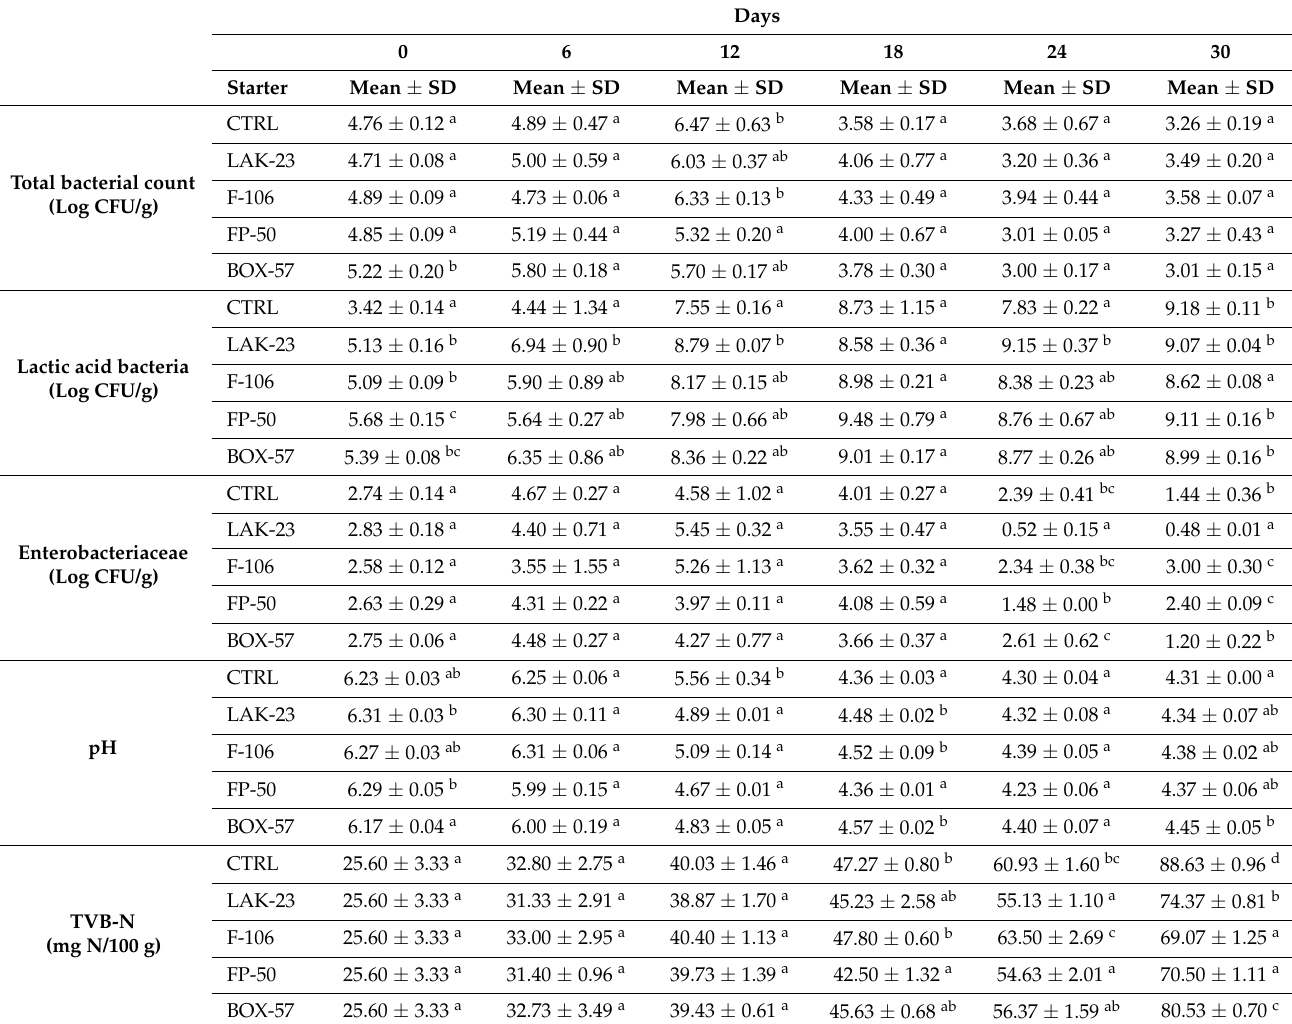
Table 1. Fate of physico-chemical and microbial characteristics of hamburgers made with a mix of sea bass and sea bream